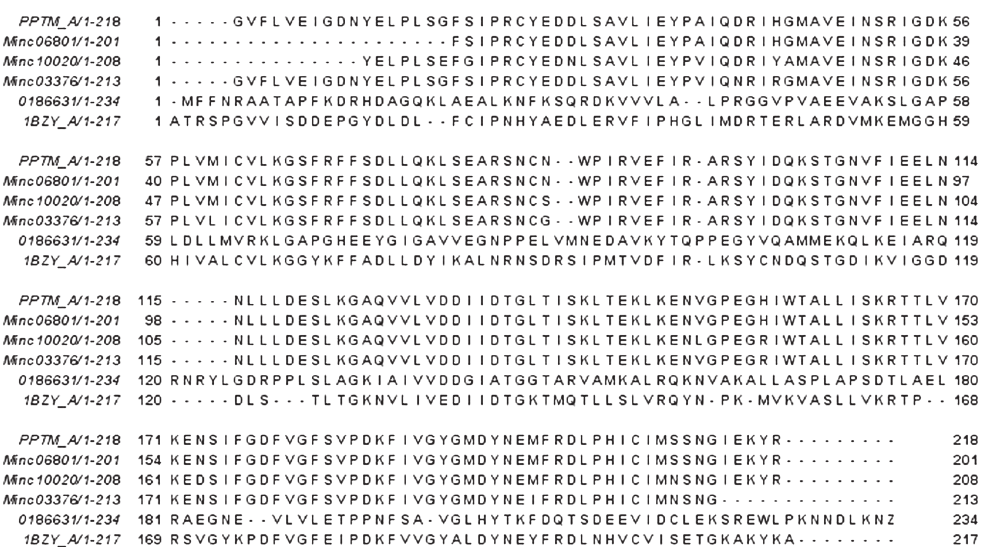
Figure 2 - Amino acid sequences from: the putative phosphoribosiltransferase from Meloidogyne incognita (PPTM_A); the genome from this nematode (prot: Minc06801, contig: MiV1ctg193; prot: Minc10020, contig: MiV1ctg367; and prot: Minc03376, contig: MiV1ctg69); chain A of 1BZY (1BZY_A), which is a human enzyme of the same class; and another putative phosphoribosyltransferase from M. incognita that was described in the literature (0186631, Kloek et al. 2005). Sequences were aligned by ClustalW 2 (Larkin et al. 2007) in SeaView 4.3.3 software (Gouy et al. 2010) and ploted by Jalview 2.7 software (Waterhouse et al.